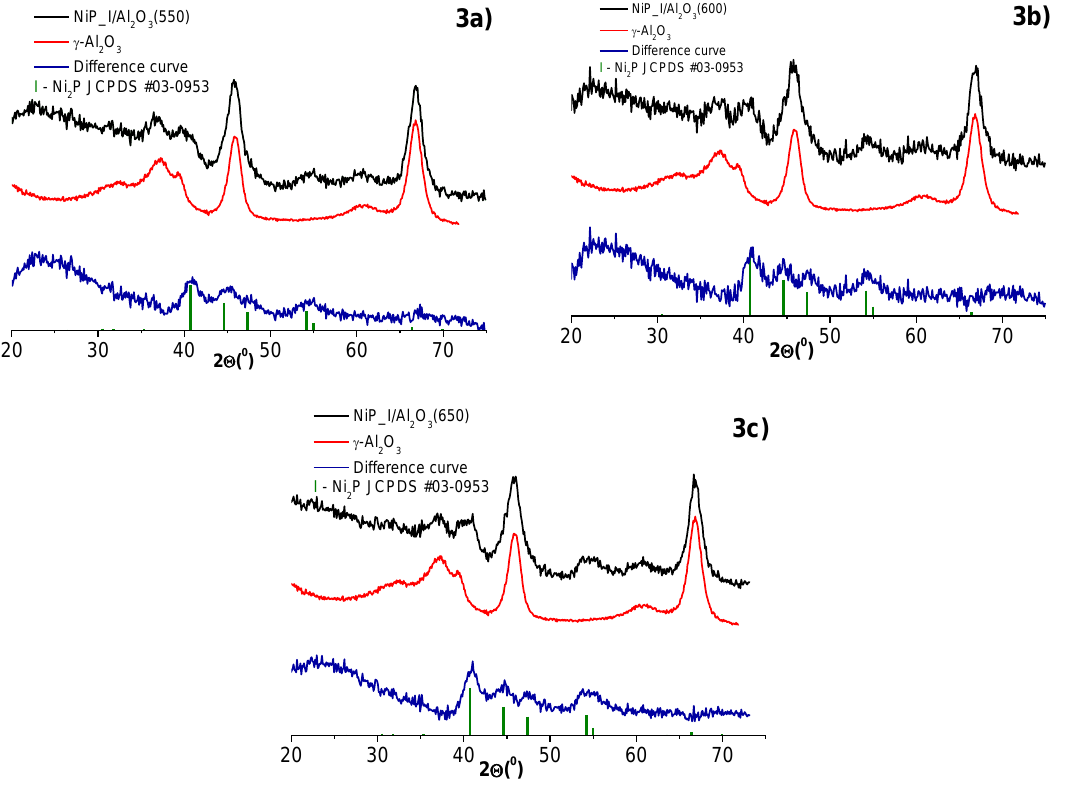
Figure 3. XRD patterns of NiP_I/Al 2 O 3 catalyst prepared from phosphite precursor and reduced at temperature of 550 ◦ C ( a ), 600 ◦ C ( b ) or 650 ◦ C ( c ), γ -Al 2 O 3 support and the difference